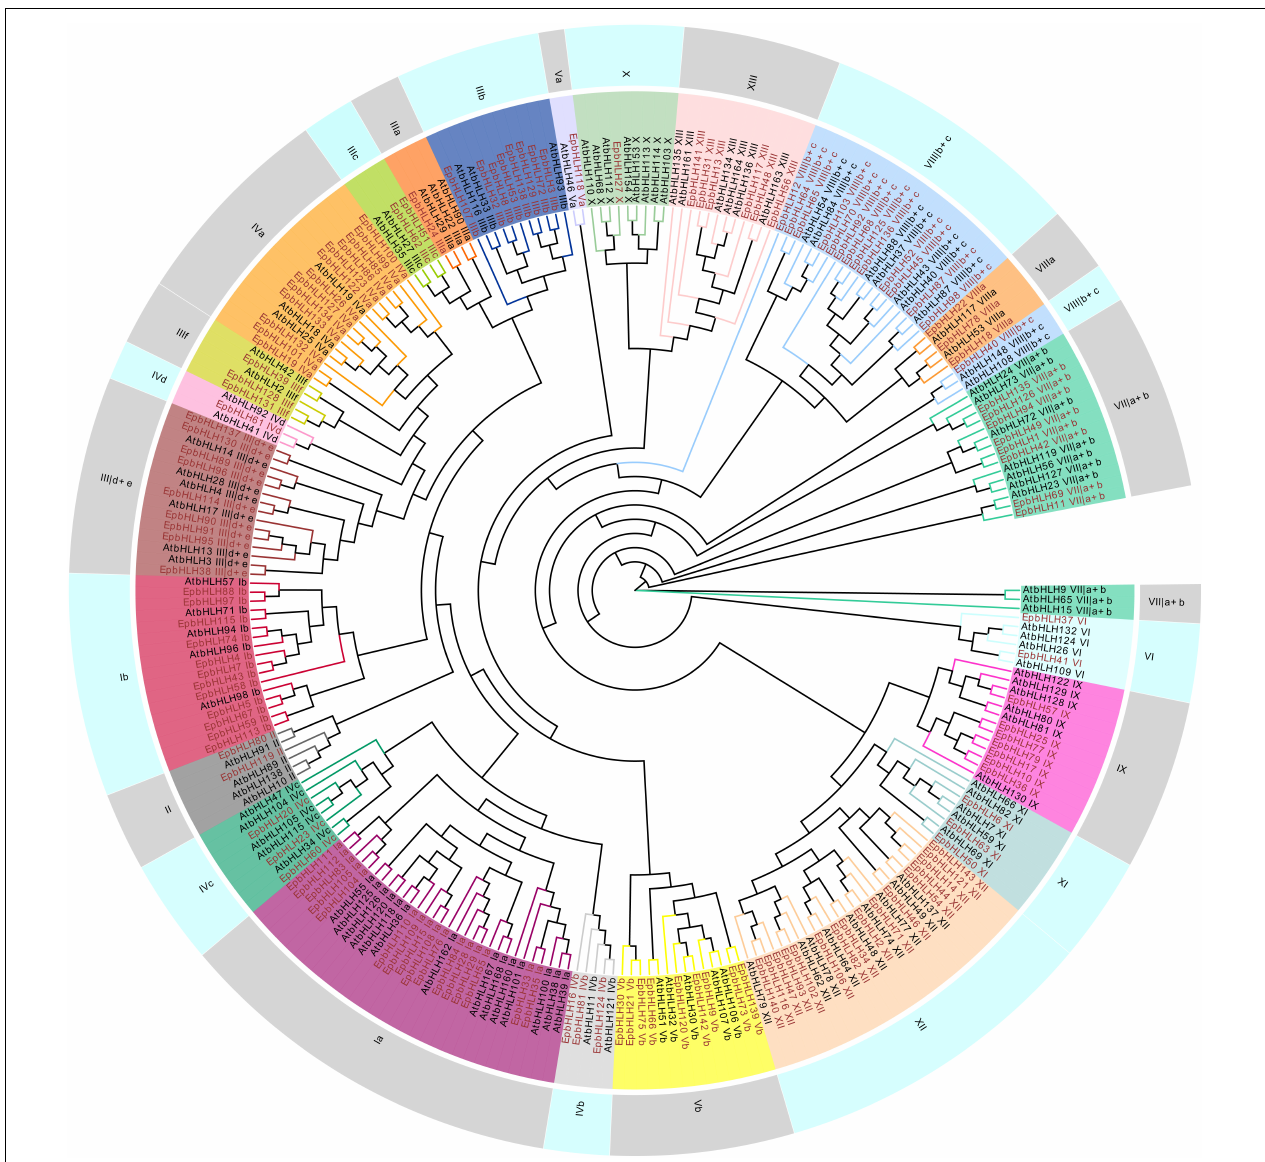
FIGURE 4 | Phylogenetic tree of EpbHLHs . The EpbHLHs are marked in red, AtbHLHs are marked in black. The subgroups are marked in different colors on the periphery of the